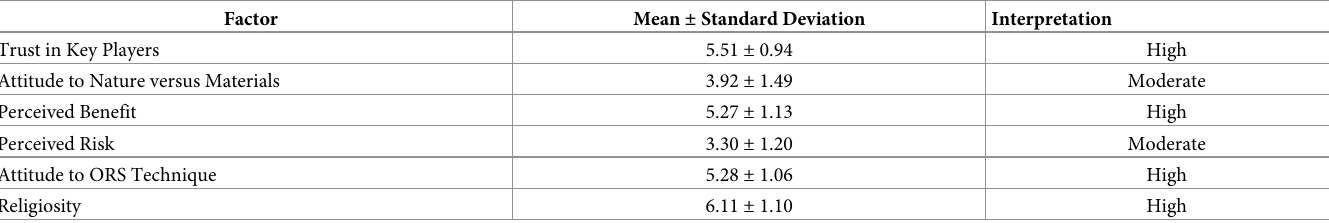
Table 2. Mean Score and Standard